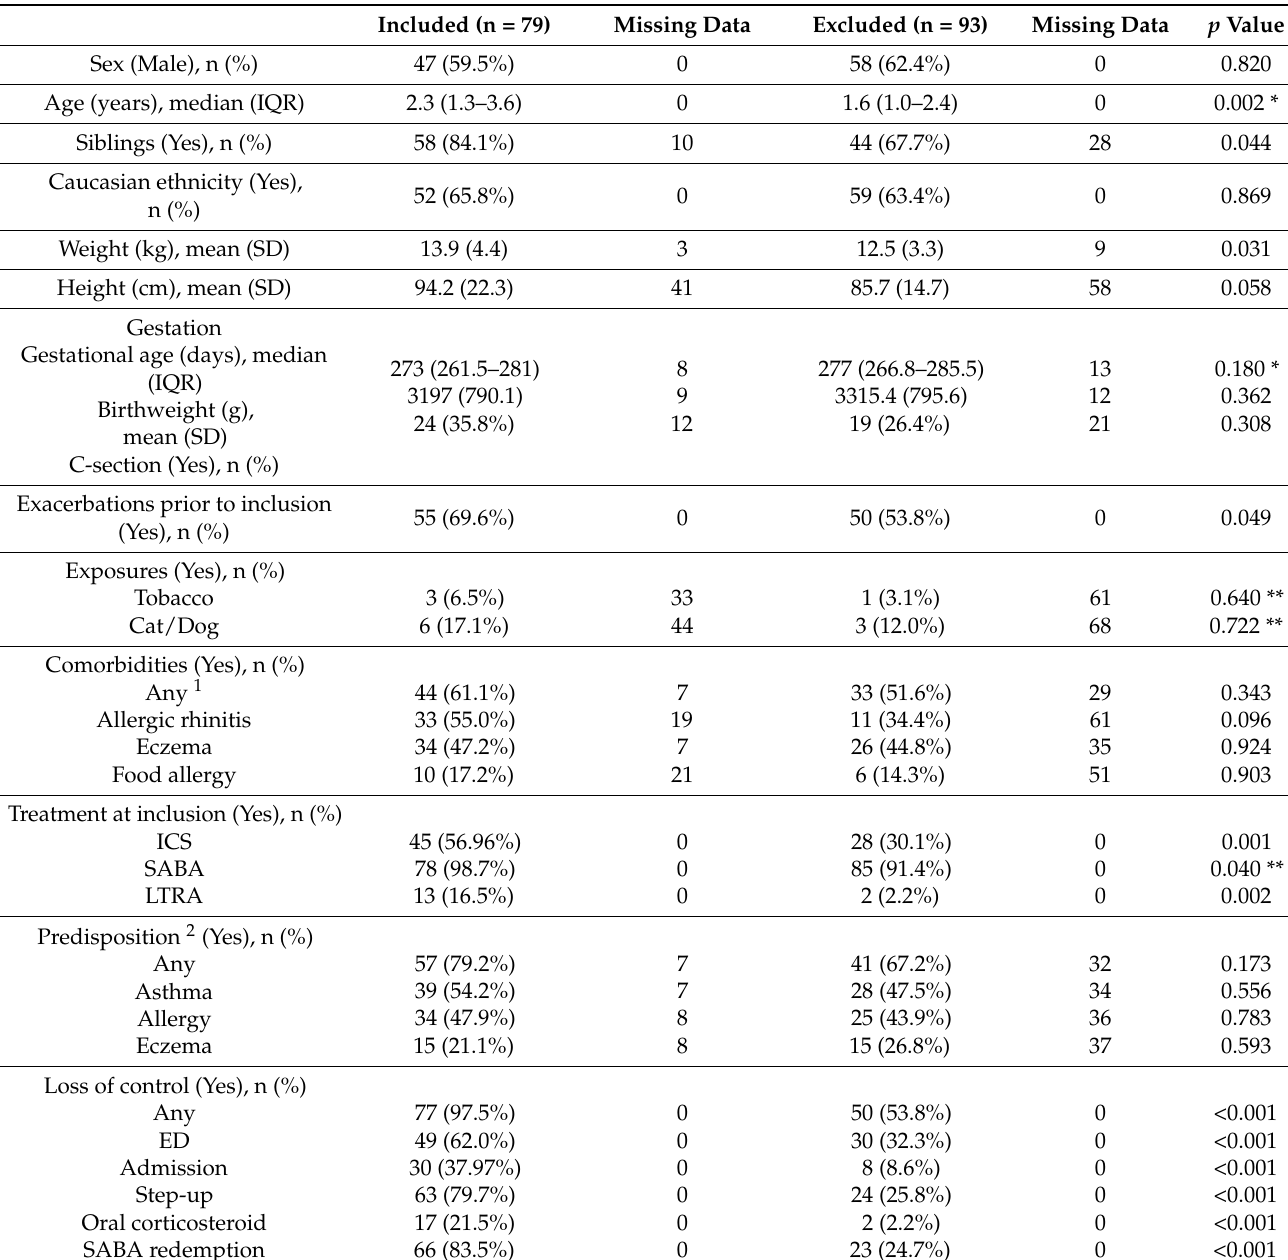
Table 1. Comparison of the included (n = 79) and excluded (n =